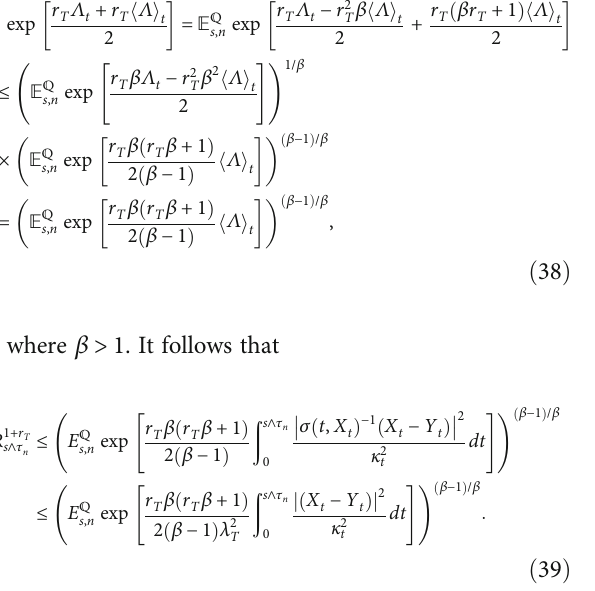
ffiffiffiffiffiffiffiffiffiffiffiffiffiffiffiffiffiffiffiffi r 1 + r T